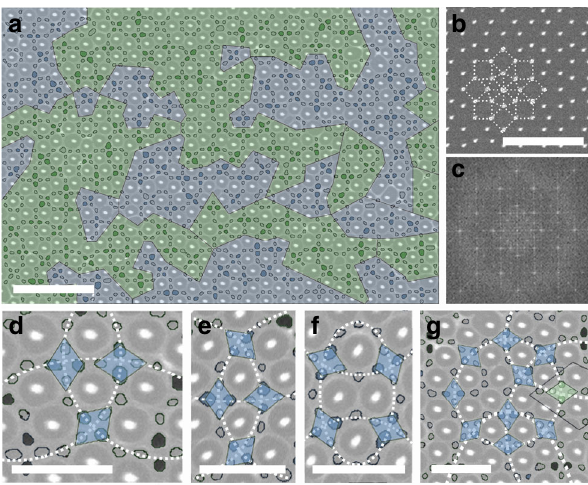
Fig. 4 BCP in quasicrystalline template. a SEM image of BCP in octagonal quasicrystalline template (Ammann-Beenker tiling). PS domain formed rhombuses in areas enclosed by square templates. The domains on the short axis of the rhombuses are highlighted. Inset is the b , post array without BCP; the dashed lines indicate the local eightfold rotational symmetry, composed of square and triangular geometries. c FFT of the original SEM (FFT was processed without the contribution of post arrays). d – g rhombus-shape-forming PS domain contours, showing different ways of interaction for the rhombuses; different lines indicate the alternating rhombuses orientations. The scale bars in a and b are 500 nm, and the scale bars in d – g are 200